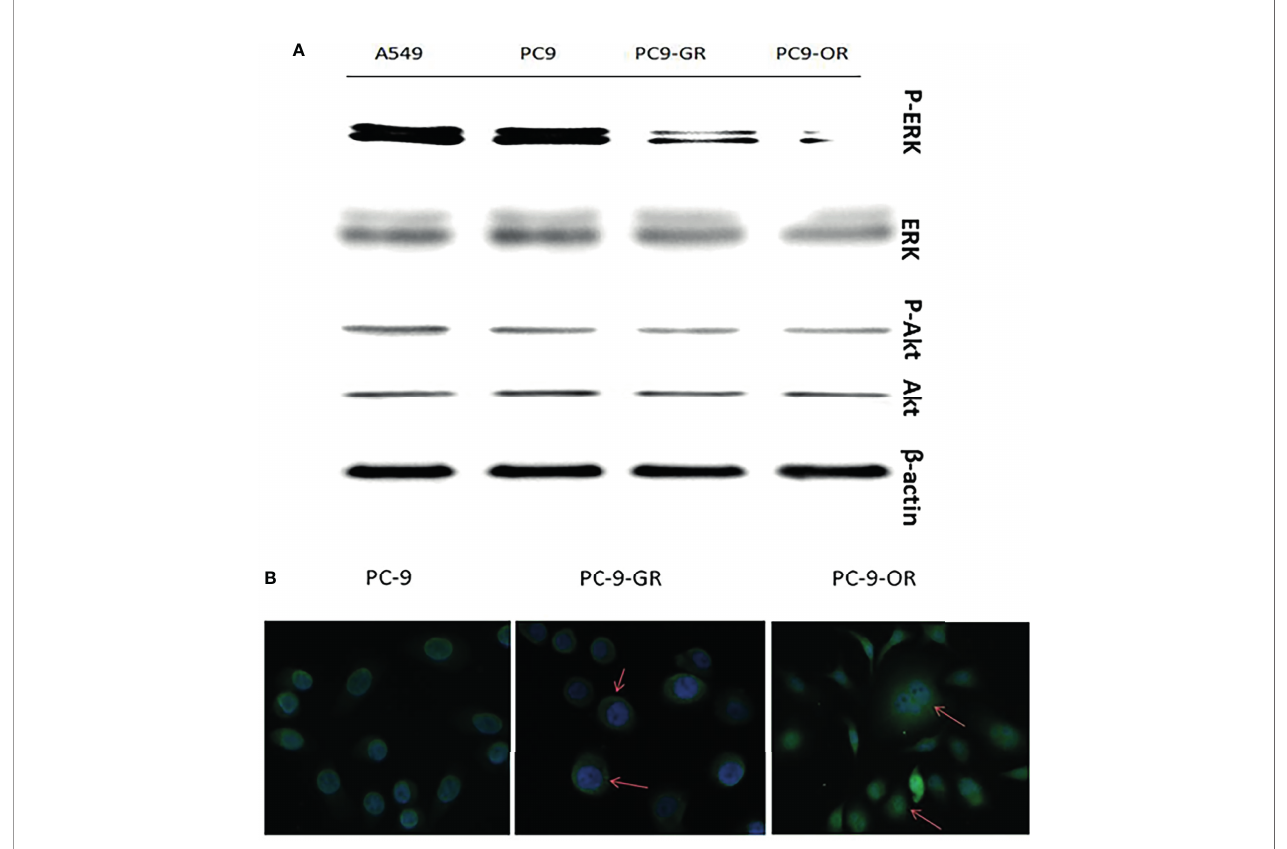
FIGURE 3 | The changes of expression levels of p-ERK1/2 and P-AKT with the development of EGFR-TKIs resistance (A) ; GPER1 translocated from nuclei to cytoplasm and membrane of tumor cells (B)